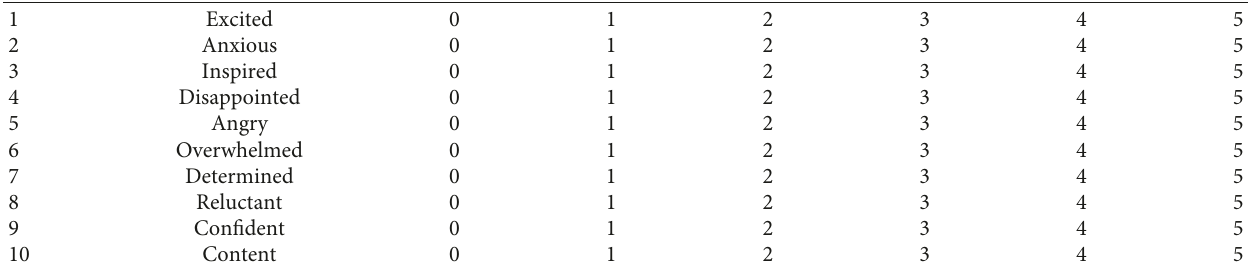
Table 6: Emotions AFTER attending the